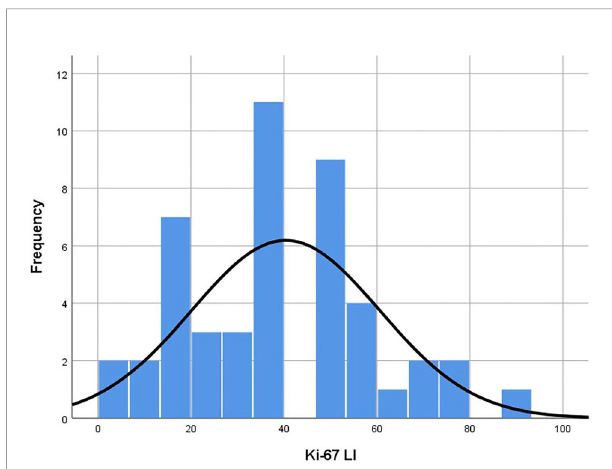
FIGURE 3 | Histogram of Ki-67 LI distribution of the lesions. Distribution was in accordance with the Kolmogorov-Smirnov test (p = 0.20). Median was 40.00 and standard deviation was 20.20. LI, labeling